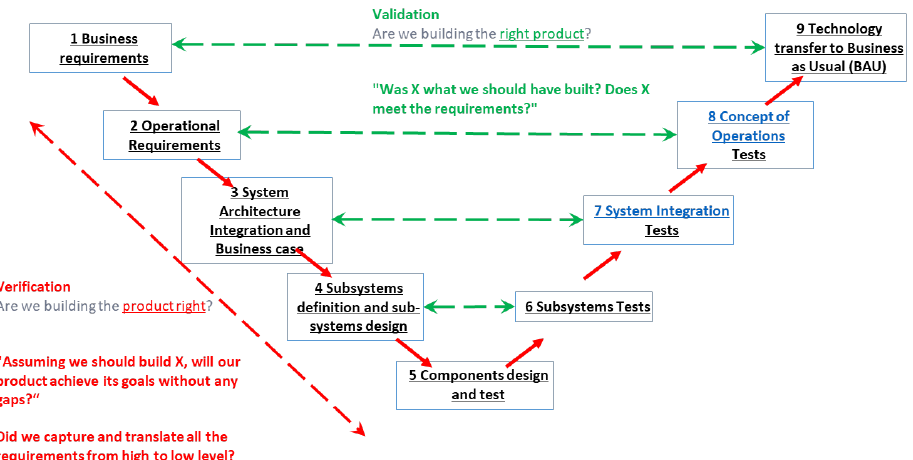
Figure 13. V-Model of Systems Engineering as a basis for Industry 4.0 implementation in composite manufacturing firms.